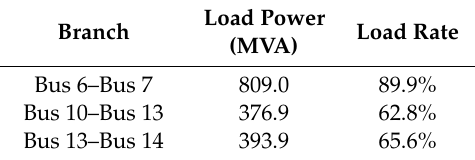
Table 5. Load Conditions of Target Branches After